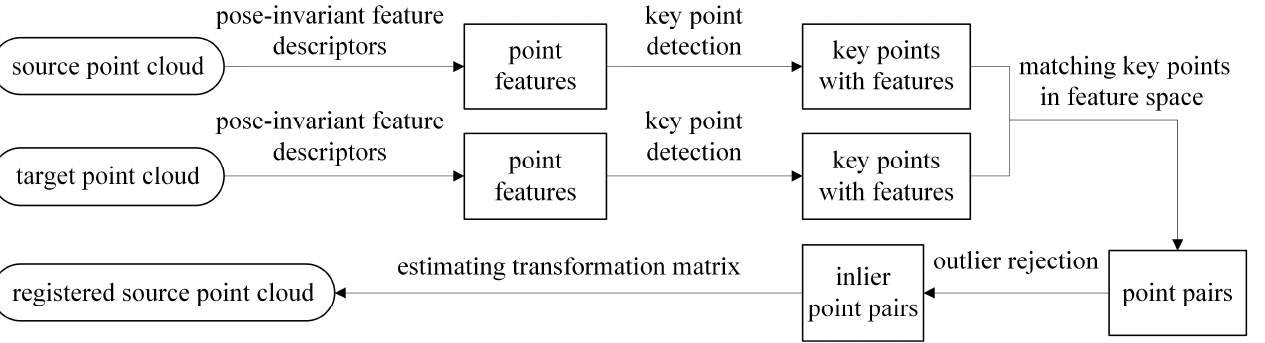
Figure 4. The pipeline of the ‘hybrid’ and ‘end ‐ to ‐ end’ algorithms relying on pose ‐ invariant features.